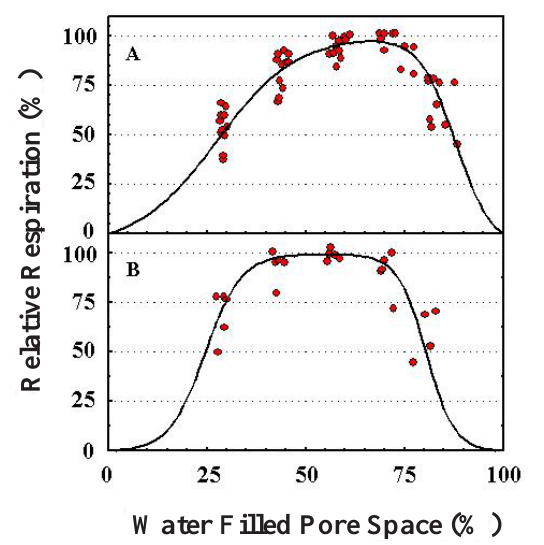
FIGURE 1. The effect of WFPS on relative microbial respiration for fine-textured (A) and coarse-textured (B) soils (data from Doran et al.[16]). Lines represent the sum of two supplementary GEMLS fits to the data.